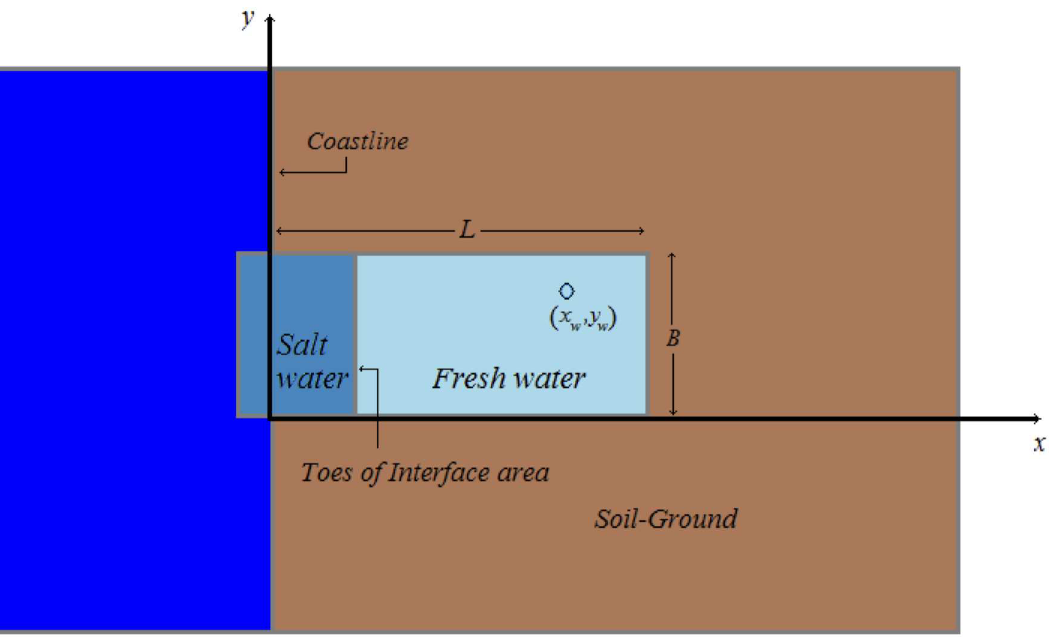
Fig 3. Homogeneous rectangular